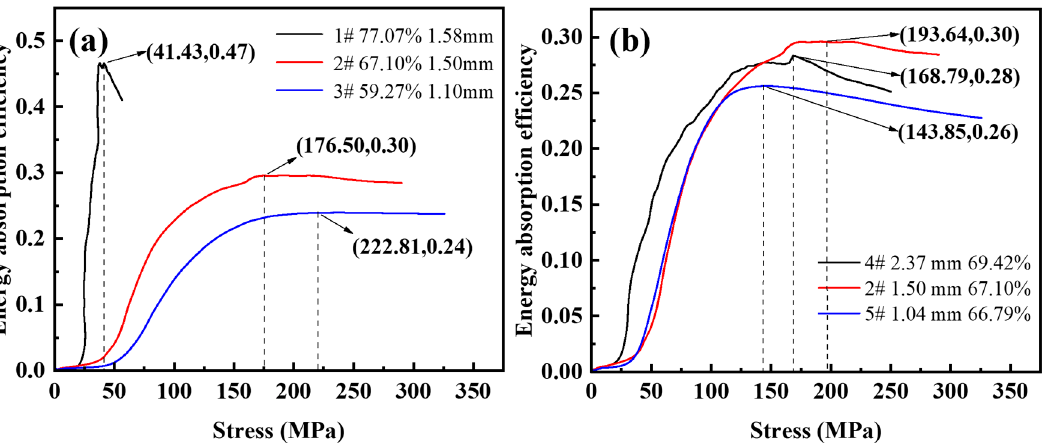
Figure 9. Energy absorption efficiency-stress curve of ( a ) different porosity and ( b ) different pore size.